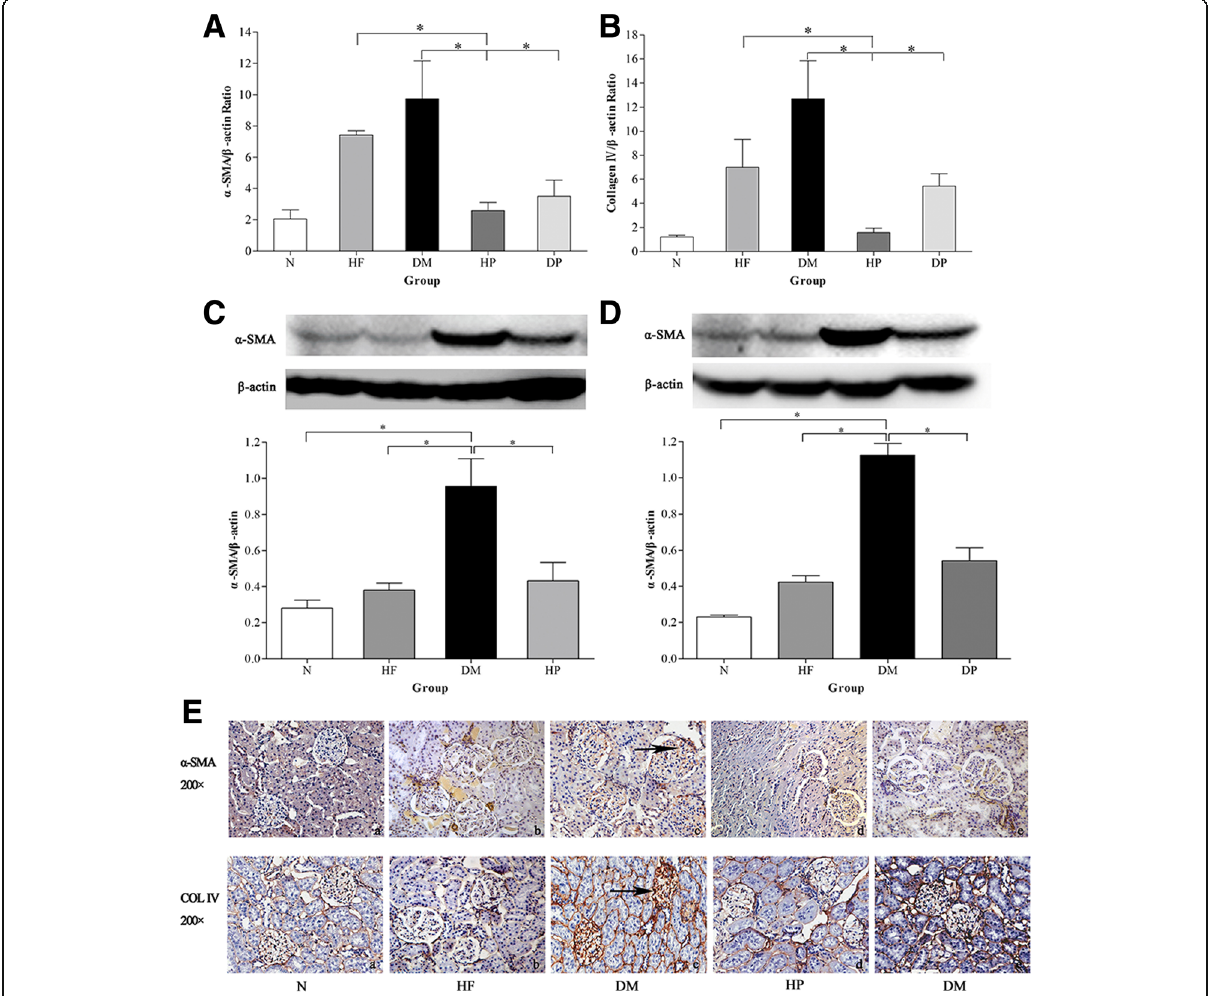
Fig. 5 The expression of α -SMA and collagen IV in renal. The mRNA expression of α -SMA a and collagen IV b ; the protein expression of α -SMA determined by Western blot c and d and immunohistochemical e ; the protein expression of collagen IV determined by immunohistochemical f . The data are presented as mean ± SEM, n ≥ 3, * p <